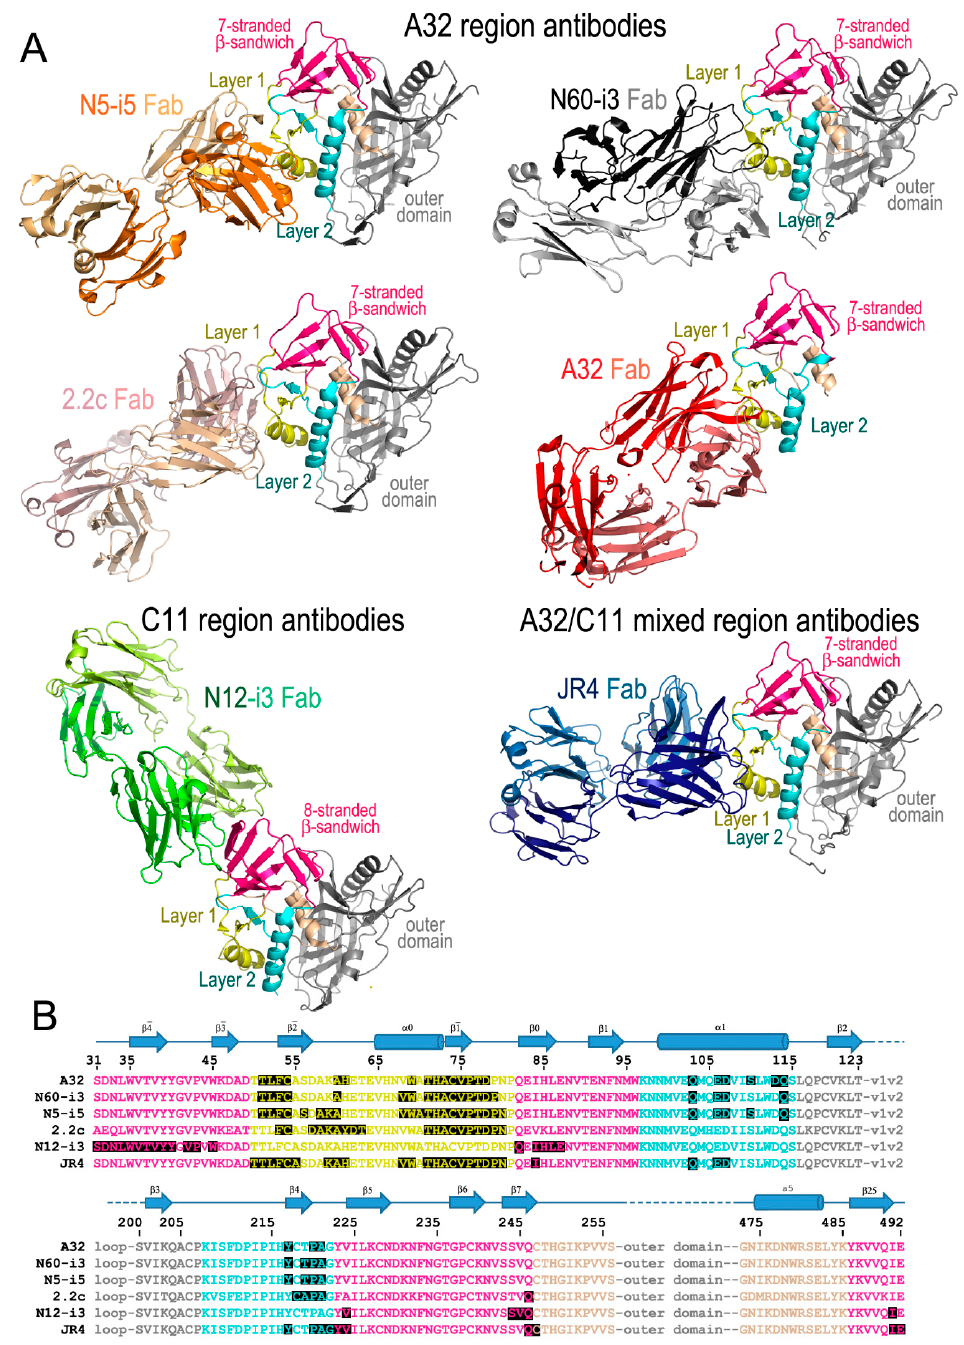
Figure 1. Cluster A antibodies in complex with gp120 antigens. ( A ) Structures shown are of: N5-i5Fab-gp120 93TH057 core e -d1d2CD4 (PDB code: 4H8W), N60-i3Fab-gp120 93TH057 core e -M48U1 (4RFO), 2.2cFab-gp120 YU2 core e -M48U1 (4R4F), A32Fab-gp120 93TH057- ID2 (4YC2), N12-i3Fab-gp120 93TH057 core e +N/C-M48U1 (5W4L), and JR4Fab-gp120 93TH057 core e -M48 (4RFN). For each complex only the gp120 and Fab molecules are shown as ribbon diagrams. Images were generated with Pymol (The PyMOL Molecular Graphics System, Version 2.0 Schrödinger, LLC, San Carlos, CA, USA). ( B ) The binding footprint of each antibody highlighted in black. Colored text corresponds to the areas depicted in A; pink: seven- /eight-stranded β -sandwich, yellow: gp120 mobile layer 1, light blue: mobile layer 2, beige: layer 3, and grey: the gp120 outer domain. gp120 secondary structure elements are depicted above the sequence as arrows for β -strands and cylinders for α